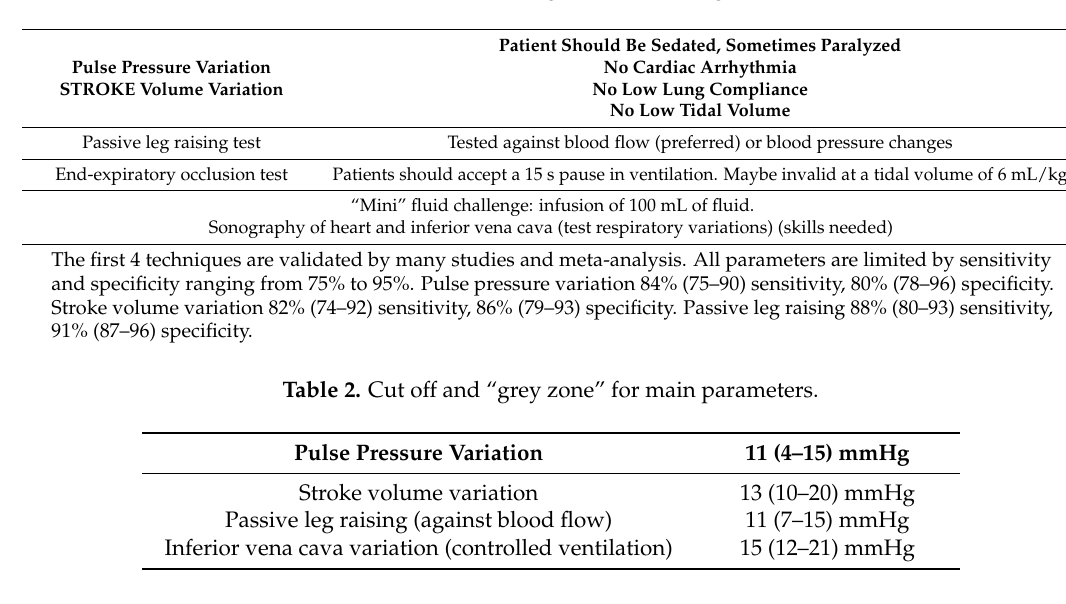
Table 1. Monitoring of fluid challenge.